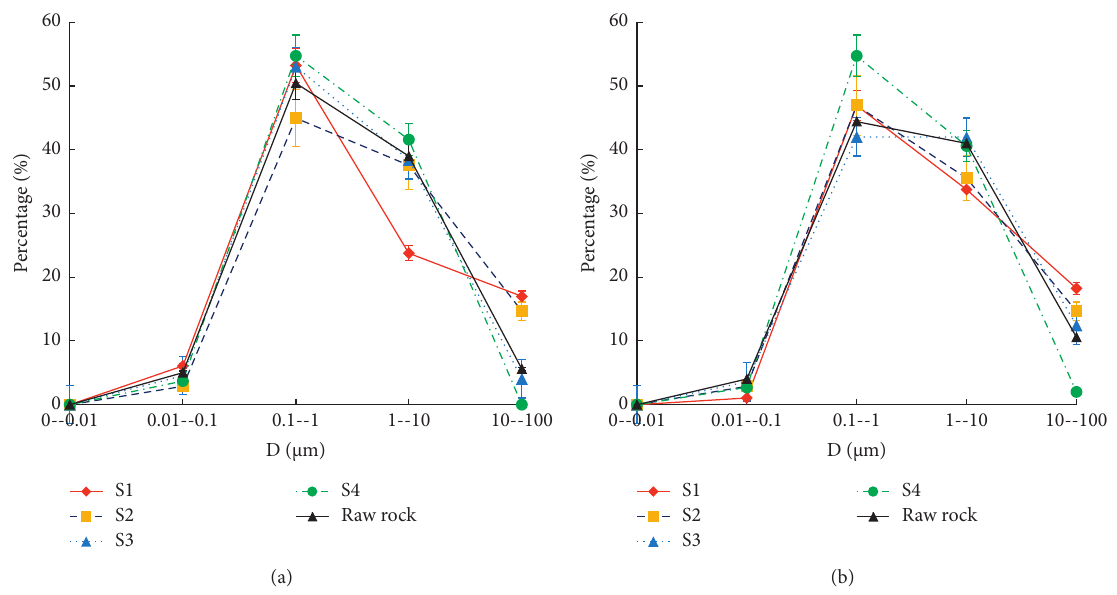
Figure 14: Relationship between pore area ratio and pore diameter: (a) in the horizontal plane and (b) in the vertical